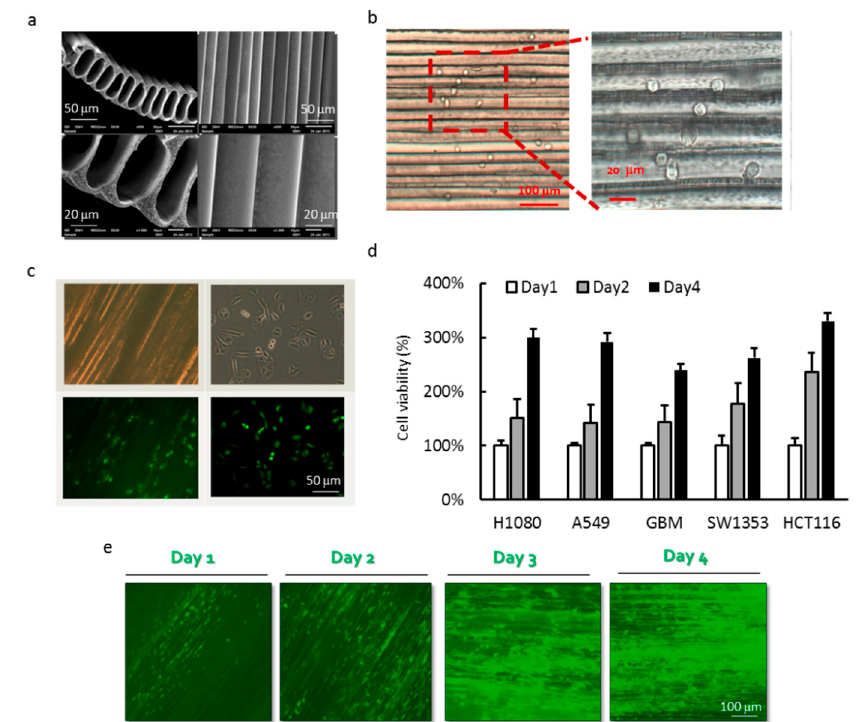
Figure 1. ( a ) SEM view of the top and transverse section of the MTAM depicting the microstructure of the electrospun MTAM; ( b ) optical microscopy image of the A549 cells loaded (siphoned) into the respective lumens of the MTAM; ( c ) the GFP-GBM cells that were loaded at a cell density of 1 × 10 6 cells/mL and its corresponding optical microscopy image; ( d ) cell viability of various cancer cell lines that were cultured in MTAM that demonstrated excellent cell viability; and ( e ) Calcien-AM stained optical microscopy images of GBM cultured on MTAM. Results are expressed as mean data from six fibers (Student’s t-test; P < 0.05).